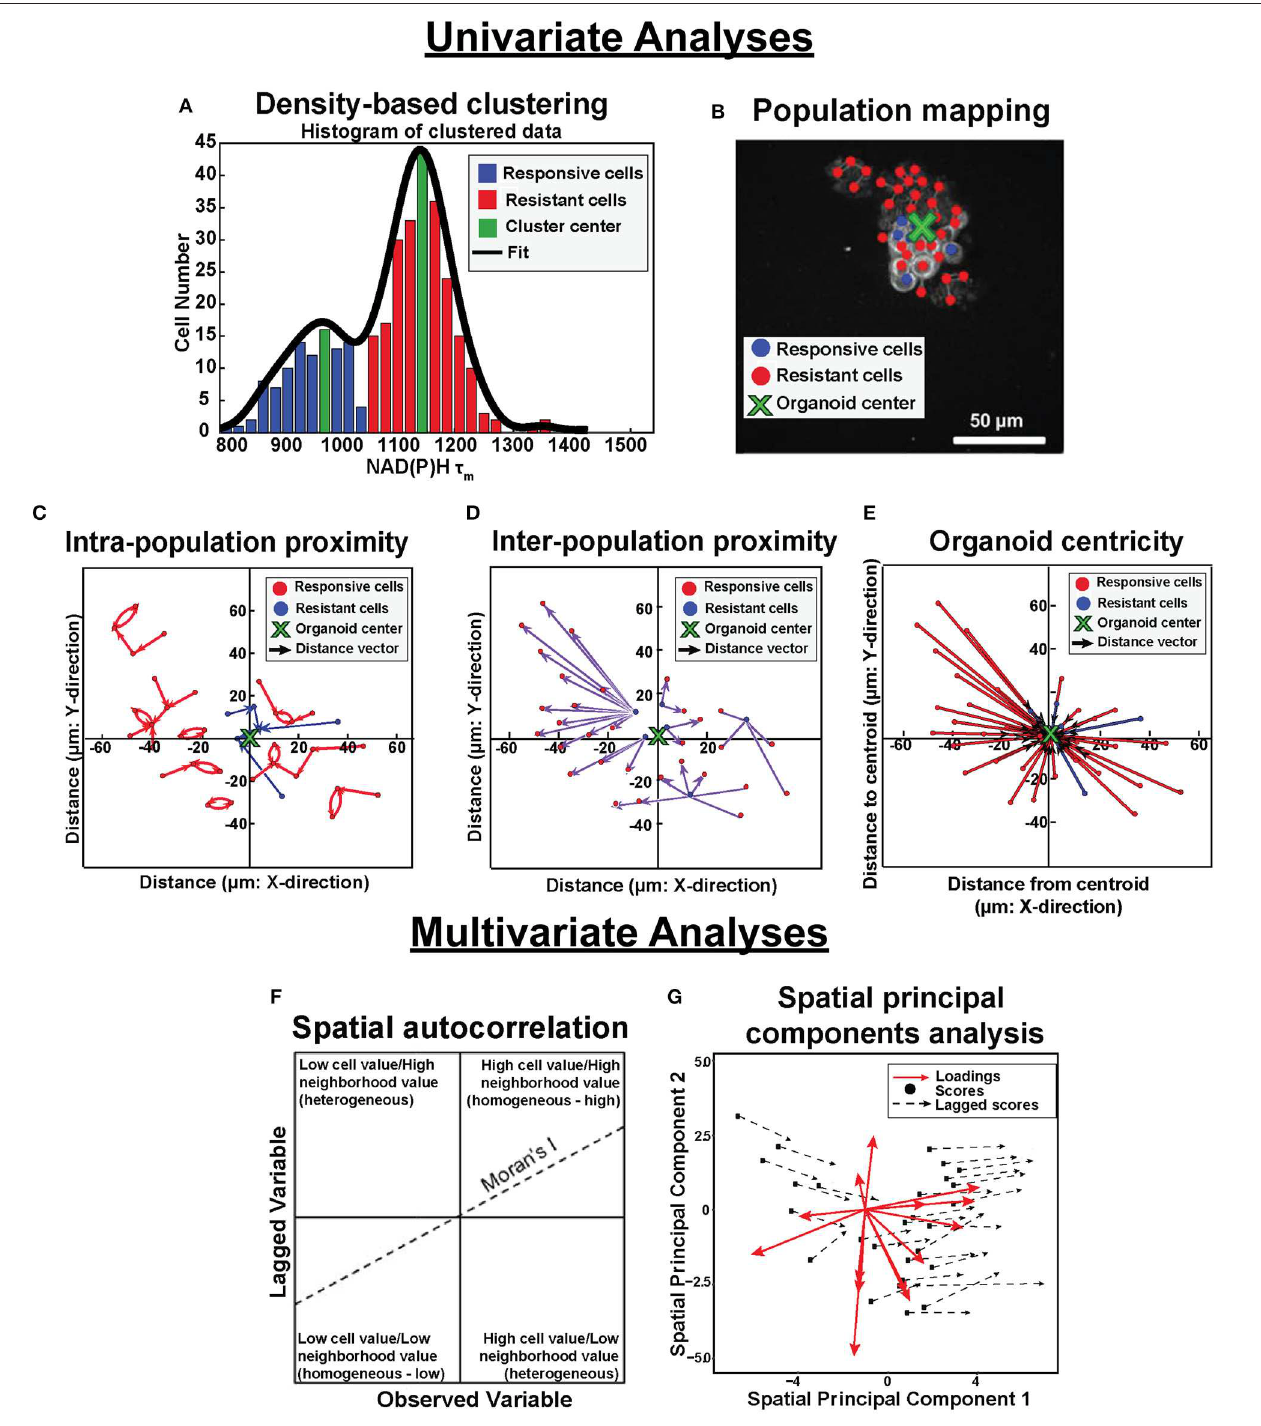
FIGURE 1 | Population density analysis and spatial statistical analysis quantify spatial heterogeneity of cell metabolism. Single variable analyses using NADH τ m data is outlined in (A–E) . (A) Frequency histograms of single-cell NAD(P)H τ m values (blue, green, red bars) are fit with kernel density fitting (black line) to represent the data distribution. Density-based clustering analysis of NAD(P)H τ m identifies sub-populations based on cluster centers (green bins). Cells are assigned to the nearest cluster with higher local density (responsive cluster, blue bins; resistant cluster, red bins). (B) Population spatial maps of NAD(P)H τ m -defined clusters include markers of responsive cells (blue dots), resistant cells (red dots), and organoid centroid (green x) on top of the original NAD(P)H intensity image (gray). (C) Intra-population